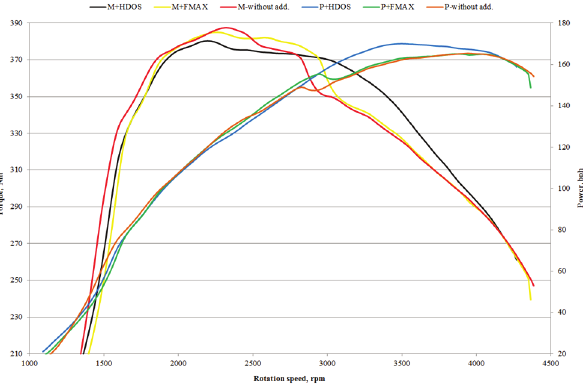
Fig. 2. Results of full load characteristic conducted on the chassis dyna-